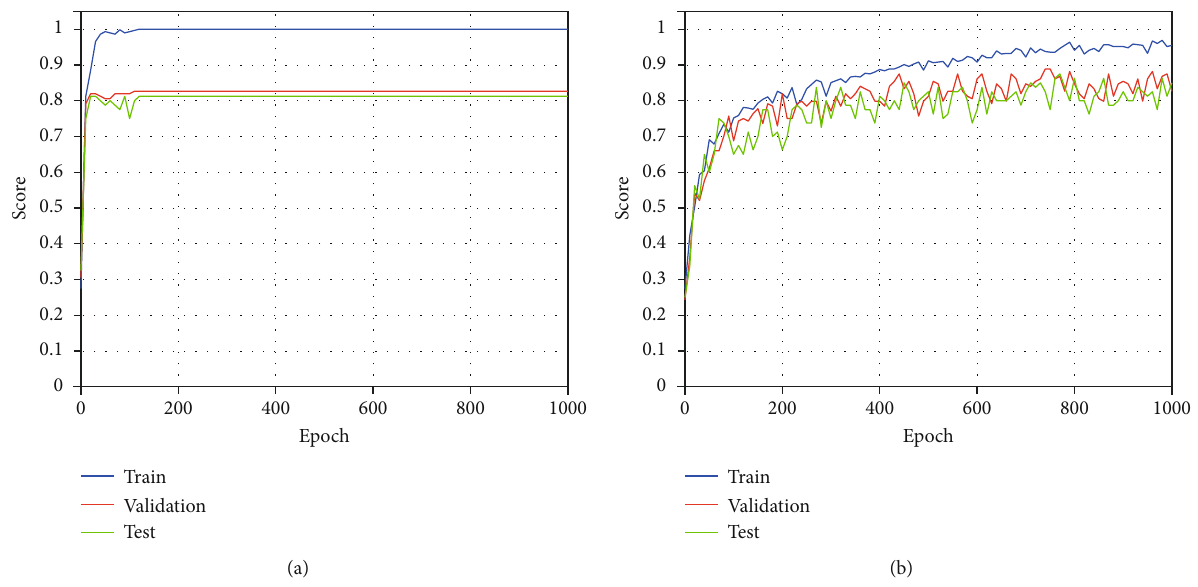
Figure 10: Accuracy scores of the ANN at dropout rates of (a) 0 and (b) 0.5.